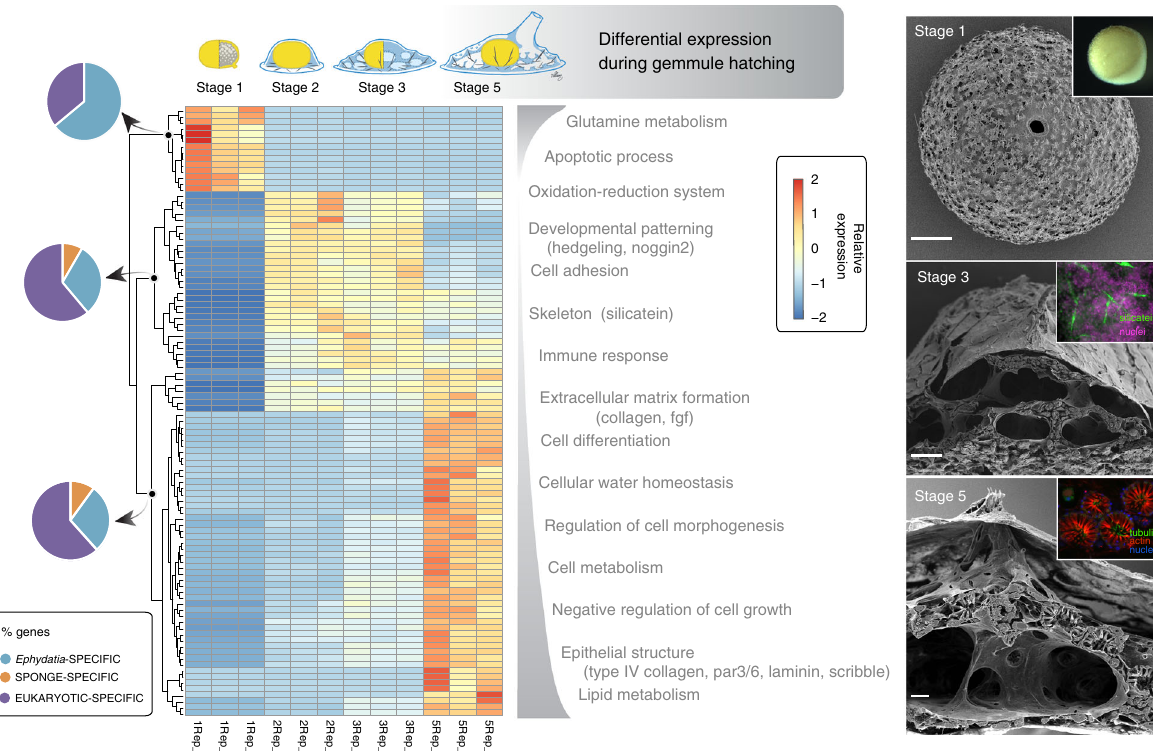
Fig. 5 Gene expression across Ephydatia muelleri development. Heatmap shows relative expression of differentially expressed genes (scale at right of heatmap) across the course of E. muelleri development, with triplicate samples for Stages 1 – 3 and 5 of growth. Note the large changes in gene expression that occur between Stages 1 and 2, and between Stages 3 and 5. These changes in expression are coincident with the occurrence of a silica-based skeleton (beginning Stage 2) and a fully formed aquiferous system including an osculum (Stage 5). Also shown on this fi gure are the GO terms matched by these genes (categories at right of heatmap) and the origin point of these genes — whether they are sponge/ Ephydatia novelties, or found more generally across the animal tree of life. E. muelleri speci fi c genes are found more commonly in Stage 1, likely a result of the specialist needs of the gemmule stage tissue represented by this sample. Images at right are of (top: bottom) a Stage 1 gemmule, taken with an SEM/light microscope (inset), a Stage 3 hatching sponge, showing the occurrence of spicules (see image top right, labelled with silicatein in green), and a Stage 5 juvenile sponge, with a well-developed aquiferous system (inset shows choanocyte chambers with collars labelled red for actin, fl agella green for tubulin and nuclei, blue). Scale bars: top 100 µ m, middle 50 µ m, and bottom 10 µ m. In these images only one replicate is shown for illustrative purposes, but in all cases the number of individual gemmules or sponges observed with these patterns was >10, for >3 replicates. Source data are provided as a Source Data fi (Supplementary Fig. 29, Supplementary Data 8). This means that, like their non-holozoan homologues, none of the identi fi ed